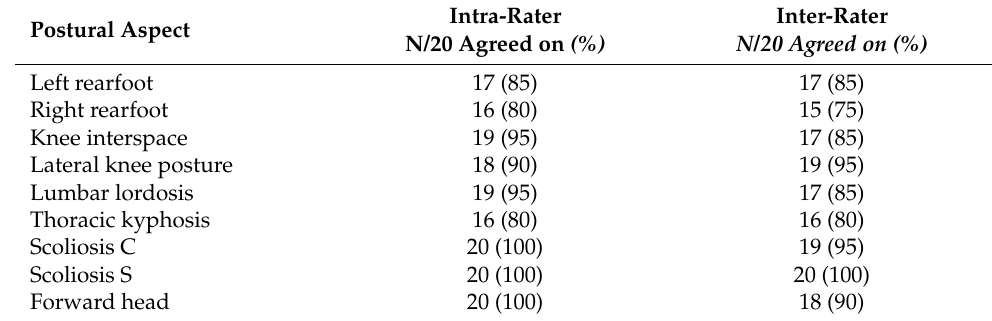
Table 2. Percent agreement between repeated measurements of posture ( n = 20) for a single rater (intra-rater) and two raters (inter-rater).